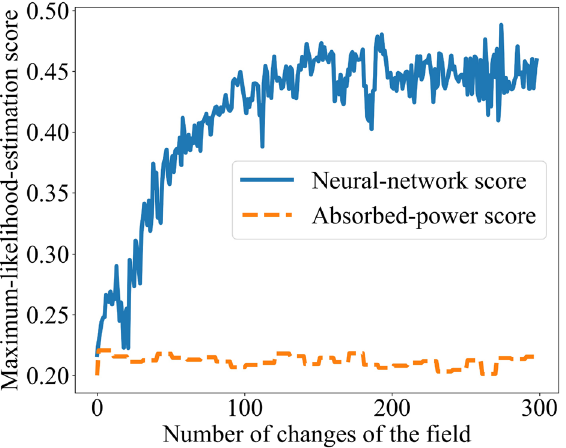
Figure 6. Quantification of memory capacity: A spin glass was trained on one of five drives in each of many trials. Each drive was formed from 40 fields selected from 50 random fields. The upper, blue line represents the memory capacity attributed to the spin glass by a bottleneck neural network. The lower, orange line represents the memory capacity attributed by absorbed